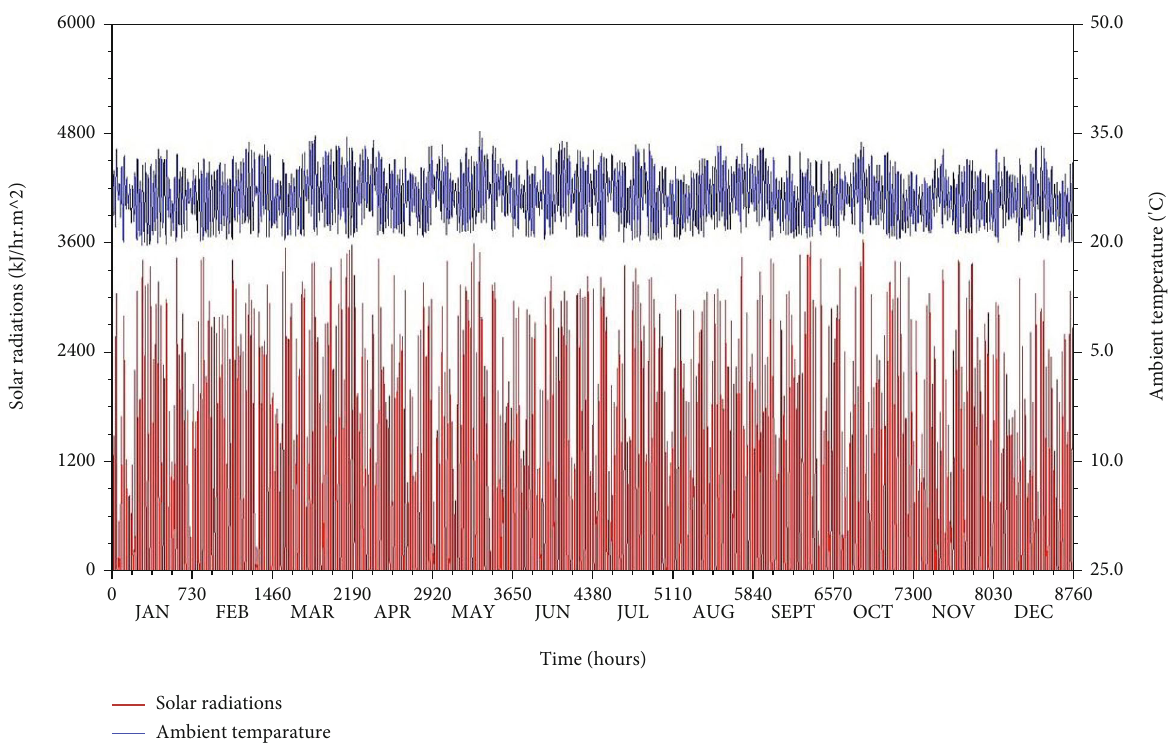
Figure 5: Annual variations of average solar radiations and ambient temperature across